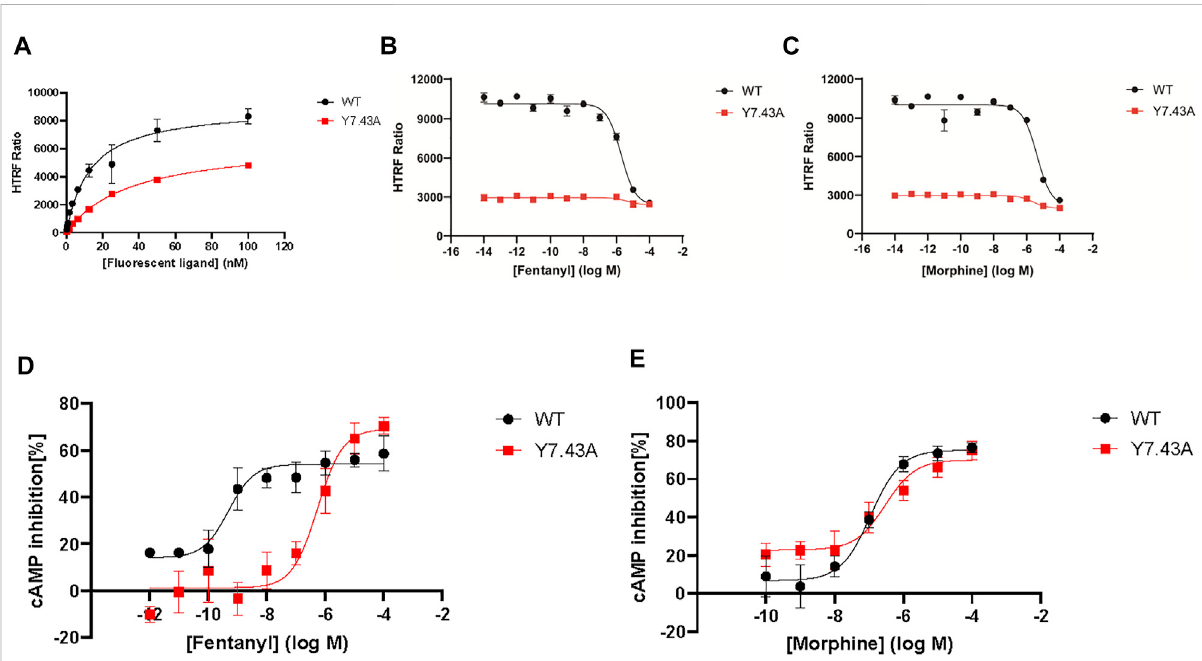
FIGURE 2 Effect of fentanyl and morphine on 10- μ M forskolin-stimulated cyclic adenosine 5 ′ -monophosphate (cAMP) accumulation in wild type (WT) and Y7.43A mutant µ-opioid receptor (MOR). (A) fl uorescent ligand saturation binding of WT and Y.43A mutant MOR. (B) homogeneous time- resolved fl uorescence (HTRF) competition binding of fl uorescent ligand to fentanyl (WT: pK i = 5.87 ± 0.06 nM; Y7.43A: pK i = 5.33 ± 0.06 nM). (C) HTRF competition binding of fl uorescent ligand to morphine (WT: pK i = 5.59 ± 0.01 nM; Y7.43A: pK i = 5.65 ± 0.11 nM). (D,E) dose – response curves for fentanyl- and morphine-induced cAMP production for WT (fentanyl: EC 50 = 0.53 ± 0.15 nM, E max = 54.18 ± 1.86%; morphine: EC 50 = 119.94 ± 52.02 nM, E max = 75.28 ± 3.09%) and Y7.43A mutant MOR transfected cells (fentanyl: EC 50 = 546.67 ± 22.78 nM, E max = 69.00 ± 0.58%; morphine: EC 50 = 291.13 ± 181.44 nM, E max = 69.86 ± 3.93% compared with WT). Data represented as mean ± standard error of the mean from three independent experiments; the statistical signi fi cance of differences between WT and Y7.43A mutant MOR analyzed using an unpaired two-tailed t -test.